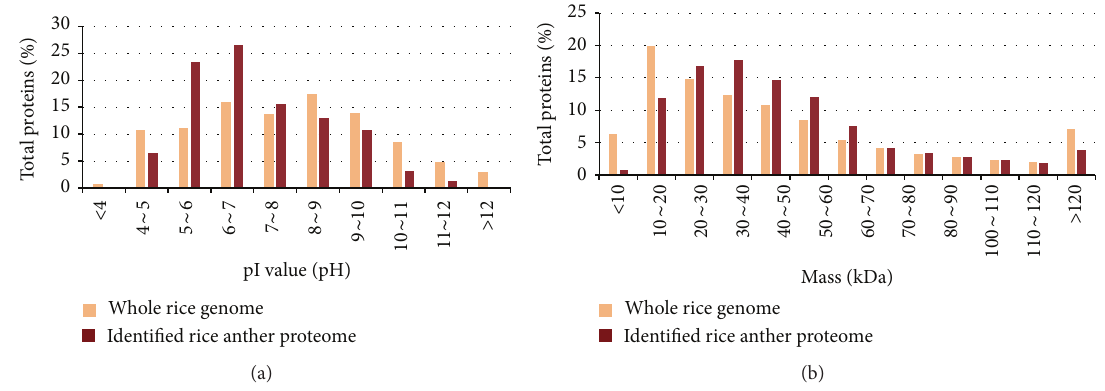
Figure 2: Distribution 𝑝𝐼 value and molecular weight of proteins extracted from (brown) Dianxi4 anthers and those of proteins encoded by the whole rice